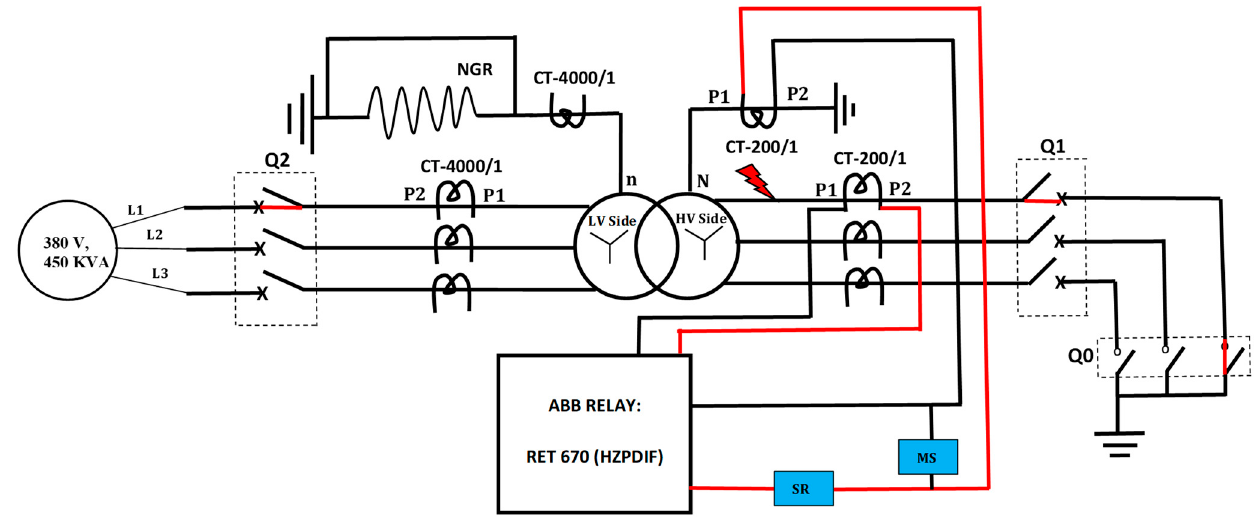
Figure 3. Proposed connection diagram for single-phase high-impedance differential protection.